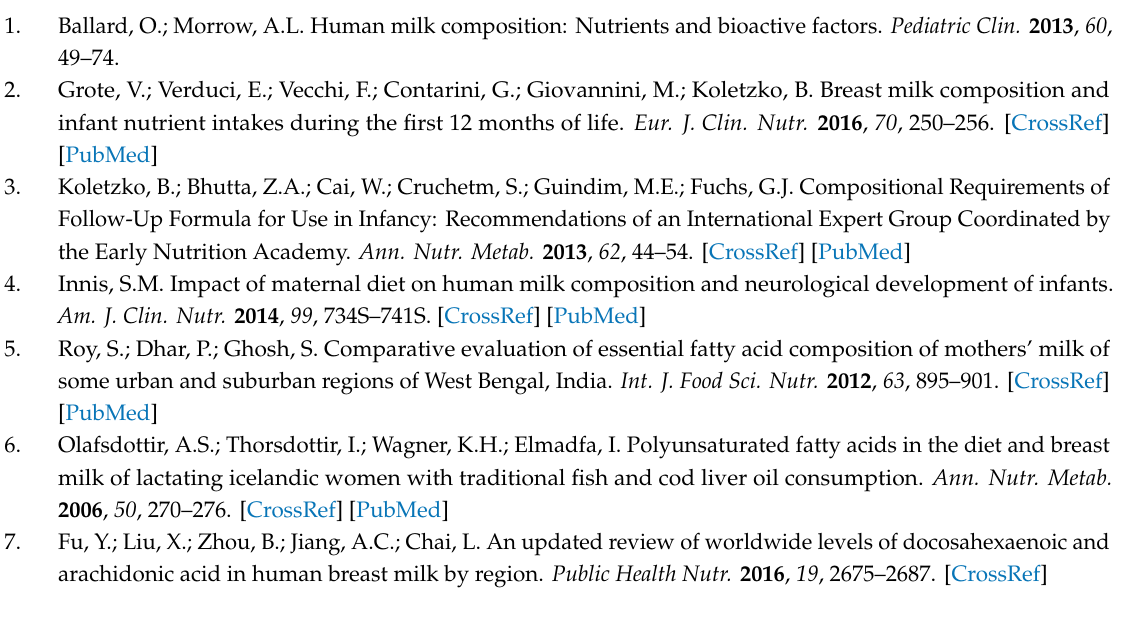
Table S1: Means and standard deviations for clr-transformed fatty acid concentrations from all human milk samples measured at 6 weeks, 6 months, and 12 months of lactation, Figure S1: Compositional biplots from principal component analysis (PCA) of centered log-ratio transformed fatty acid concentrations of human milk samples collected at 6 weeks and 6 months, Table S2: Changes in human milk fatty acid composition during the first 6 months of lactation, Table S3: Means and standard deviation for selected (32) clr-transformed individual fatty acids from human milk samples collected at 6 weeks, 6 months, and 12 months post-delivery, Figure S2: Compositional biplots from principal component analysis (PCA) of selected (32) clr-transformed fatty acid from human milk samples collected at 6 weeks, 6 months, and 12 months post-delivery, Table S3: Means and standard deviation for individual fatty acids from human milk samples collected at 6 weeks, 6 months, and 12 months post-delivery (%weight of total fatty